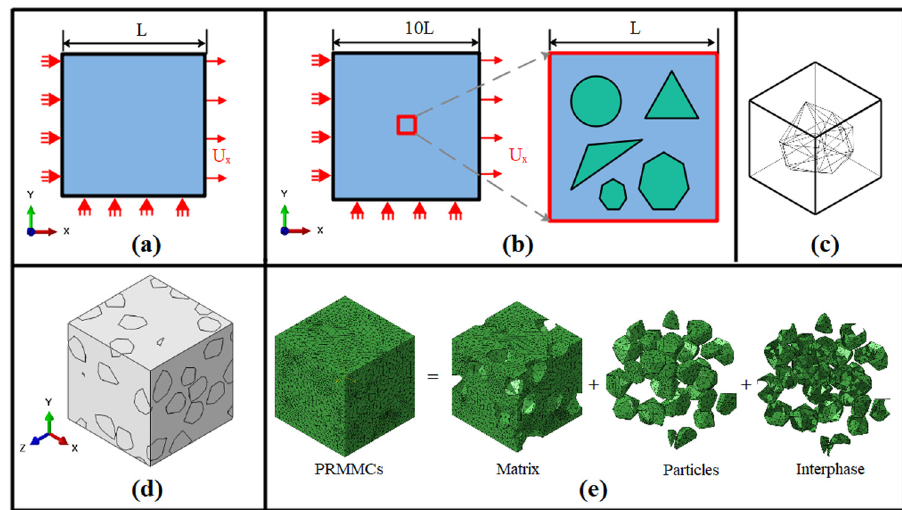
Figure 4: ( a ) Uniaxial tensile load of RVE, ( b ) uniaxial tensile load of global model and sub - model boundary conditions, ( c ) single - particle RVE geometry, ( d ) multi - particles RVE geometry, and ( e ) RVE